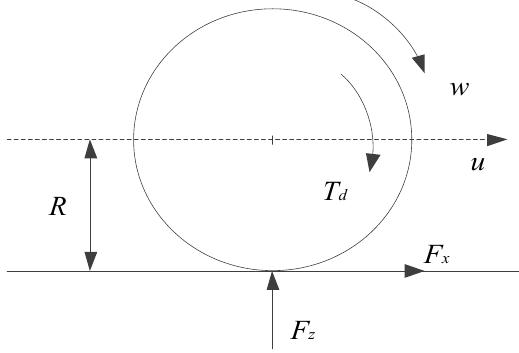
Figure 2. Wheel dynamics model.